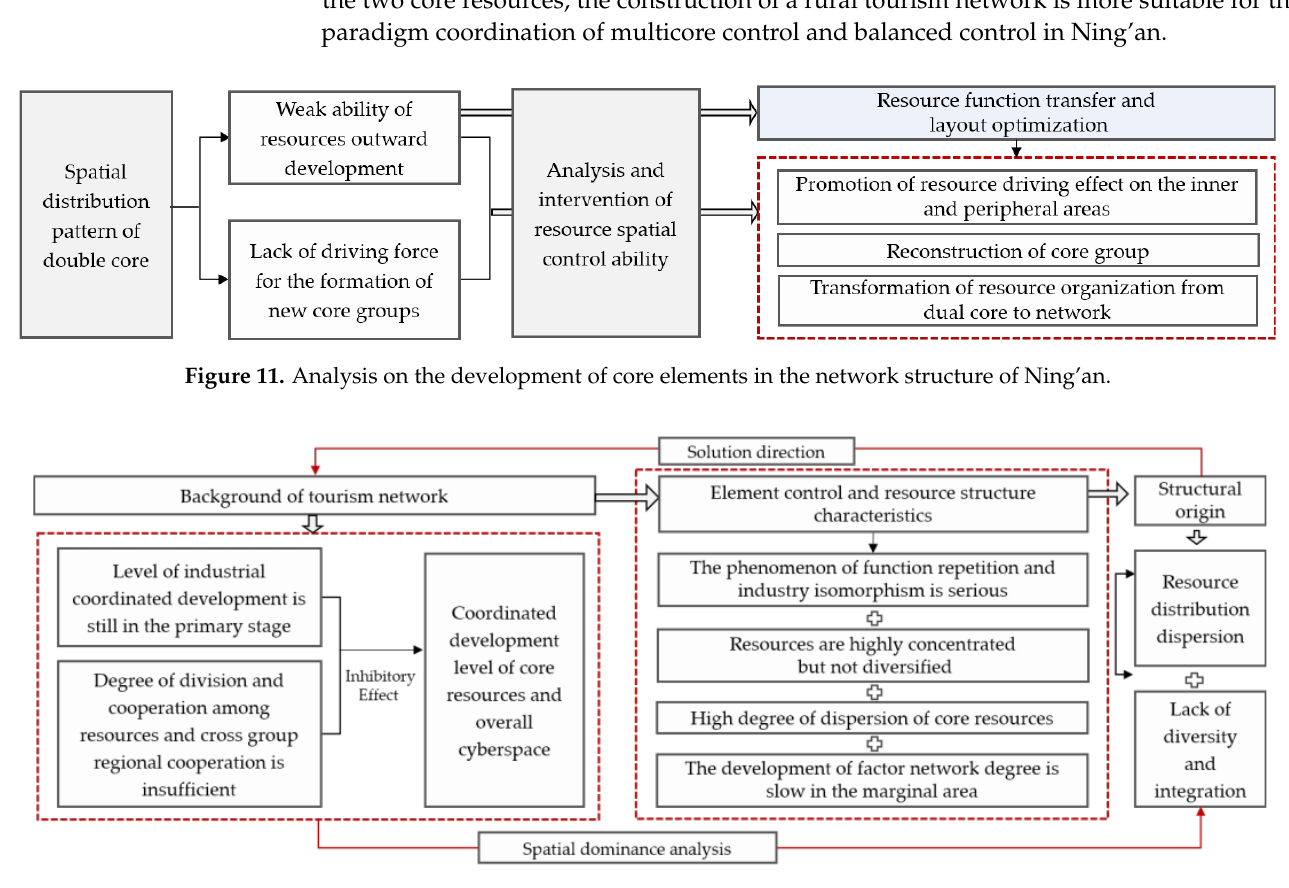
Figure 12. Analysis of development characteristics and spatial control structure thread.